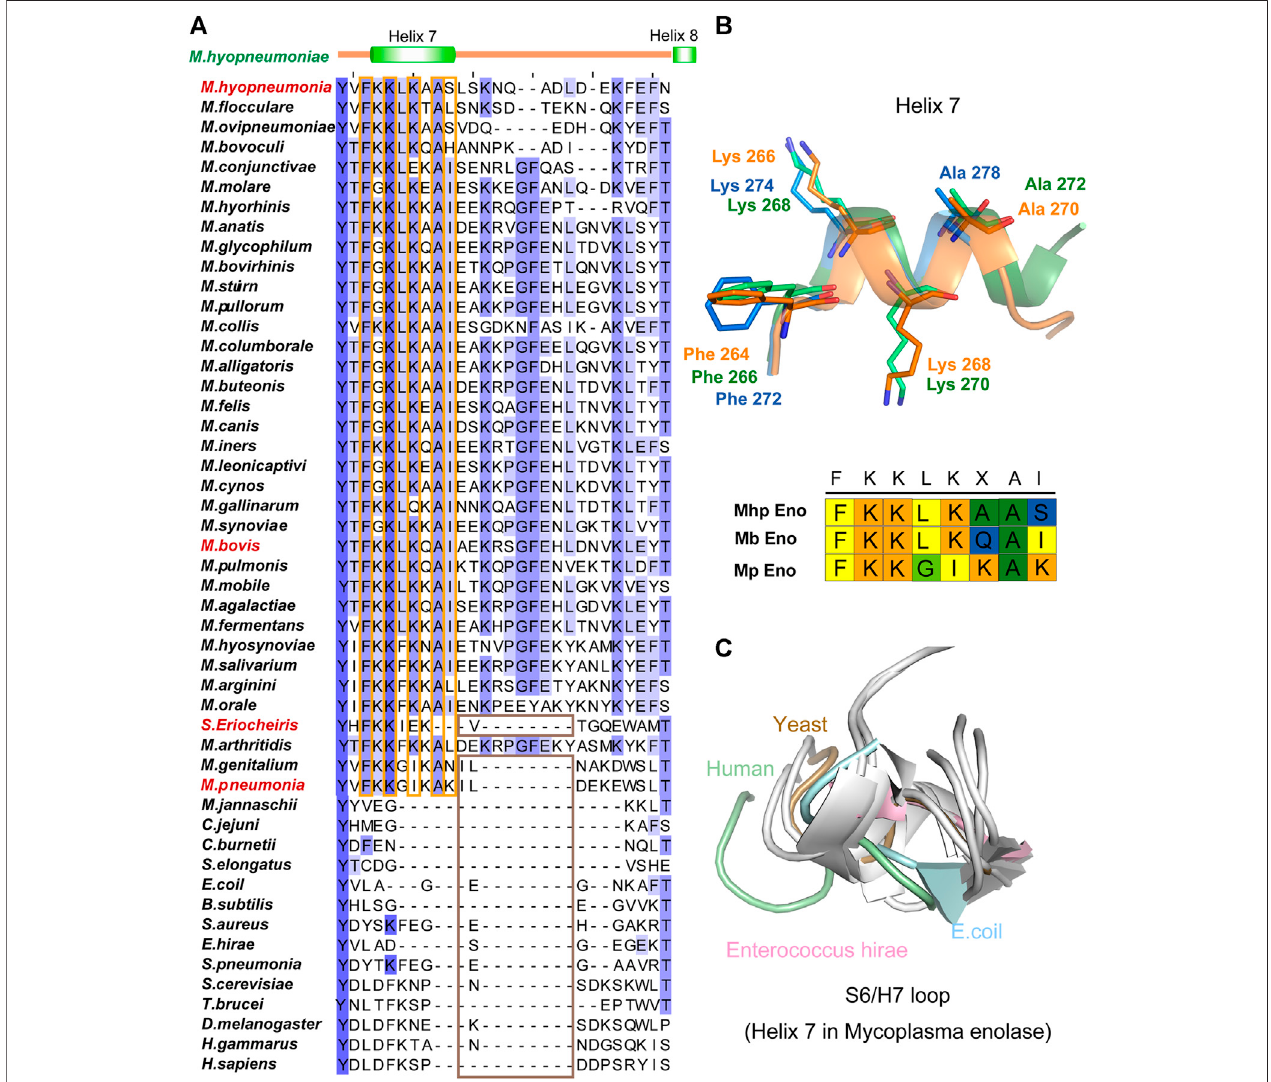
FIGURE 6 | Helix 7 motifs and structures. (A) Sequence alignment of the H7/H8 regions of different enolases. For sequence accession numbers, please refer to supplementary materials. The secondary structure of Mhp Eno is indicated above the alignments. The conserved sites in the mycoplasma enolase H7 region are highlighted with orange rectangles. The absence of H7 and H8 in enolase structures is highlighted with brown rectangles. (B) Structures of helix 7 from three mycoplasma enolases. Blue, green and orange indicate Mp Eno, Mb Eno and Mhp Eno, respectively. Conserved sites are indicated and shown stick models. The H7 motifs in Mp enolase, Mb enolase and Mhp enolase are shown under the H7 structures. (C) Structural overlap of the S6/H7 loops (corresponding to Helix 7 of Mycoplasma enolases)ofenolasesfromnon- Mycoplasma species.Enolasesfrom H.sapiens , S.cerevisiae , E.coli and E.hirae areshowninlightgreen,lightblue,brown and pink, respectively, and other enolases are shown in